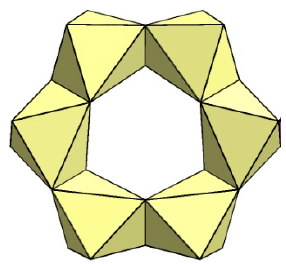
Figure 3. Six-membered ring composed of M 1 octahedra in the eudialyte-type structure.